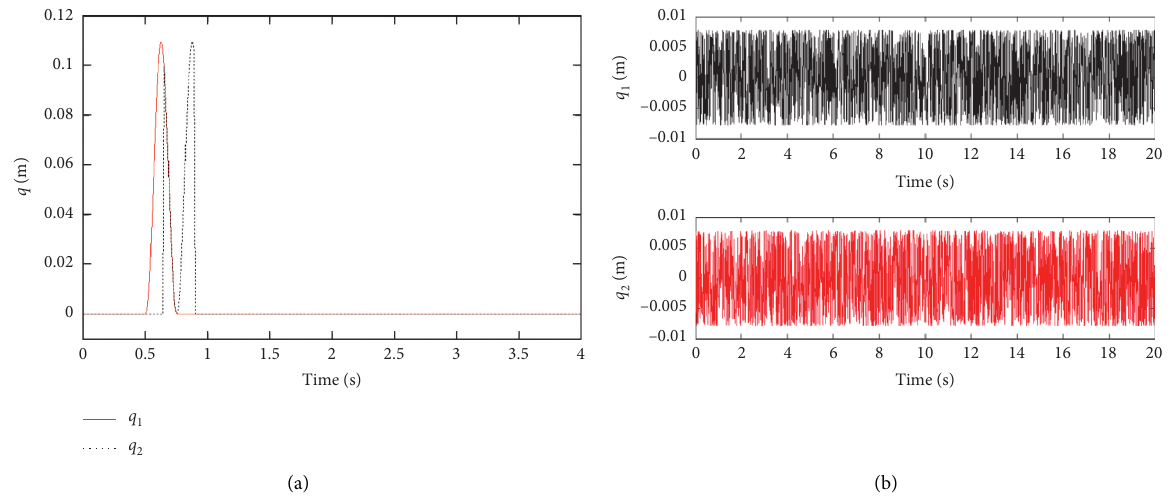
Figure 3: The response of displacements of the primary system coupling with the HNES model for v � 2m/s, h � 0.01, and T � 500 seconds seconds (a) and v 0